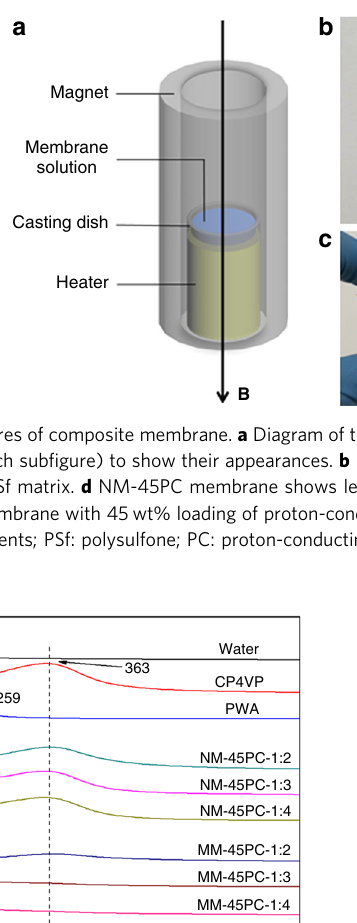
Fig. 2a, the membrane solution is decanted into a casting dish, which is horizontally placed with a heater in the upright water- cooled magnet well to evaporate the solvent, with a 35 tesla fi eld exerted. The membrane cast with the magnetic fi eld is hence referred to as magnetic-cast membrane (MM). Comparative